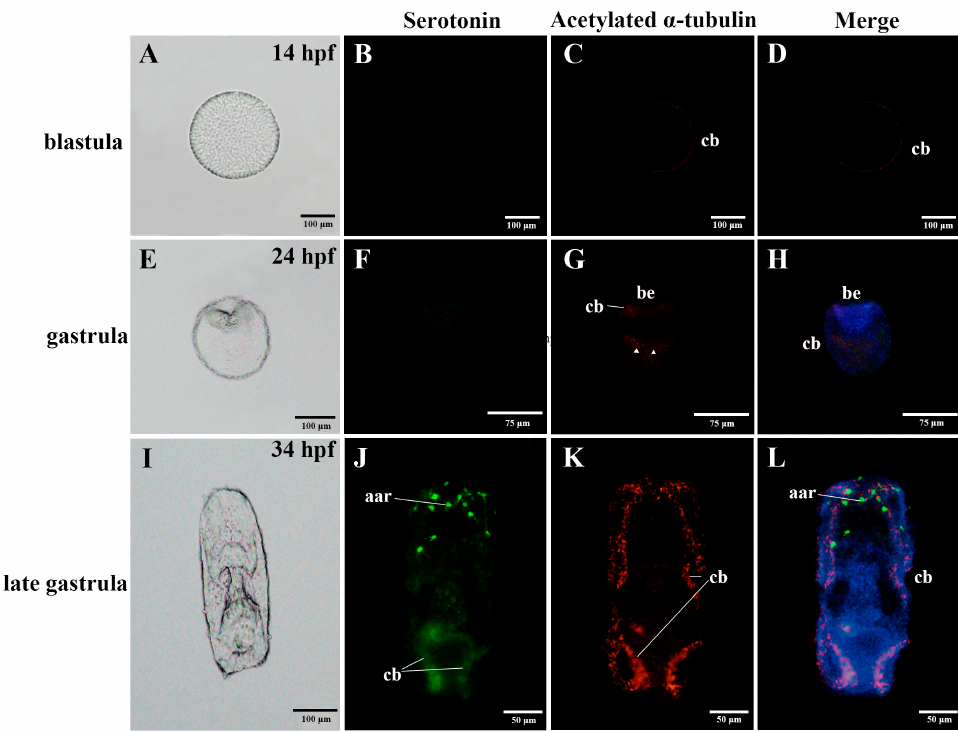
Figure 1. Anatomy diagrams and localization of the nervous system in the embryos of the sea cucumber A. japonicus , using immunofluorescence. ( A – D ) blastula; ( E – H ) gastrula; ( I – L ) late gastrula. Labels are: aar, anterior apical region; be, blastopore; cb, ciliary band. Triangles on ( G ) label the positive immunoreactions in the bottom half of the gastrula. Green, serotonin; Red, acetylated α -tubulin. Information of hpf (hours post fertilization) was labelled on the upper right of the anatomy diagrams.